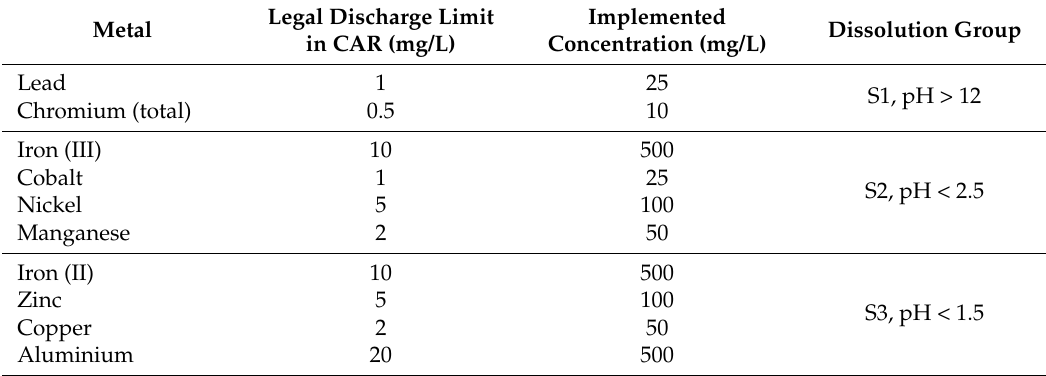
Table 3. Metal concentrations of raw dissolutions